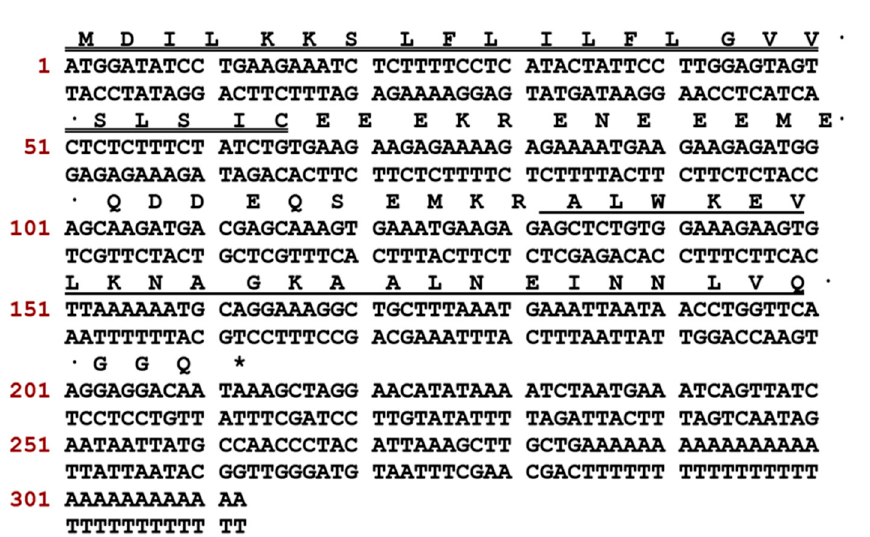
Figure 1. Nucleotide and translated open-reading frame amino acid sequences of Dermaseptin-PH from the skin secretion of Pithecopus hypochondrialis . The putative signal peptide is double-underlined, the mature peptide is single-underlined, and the stop codon is marked by an asterisk.